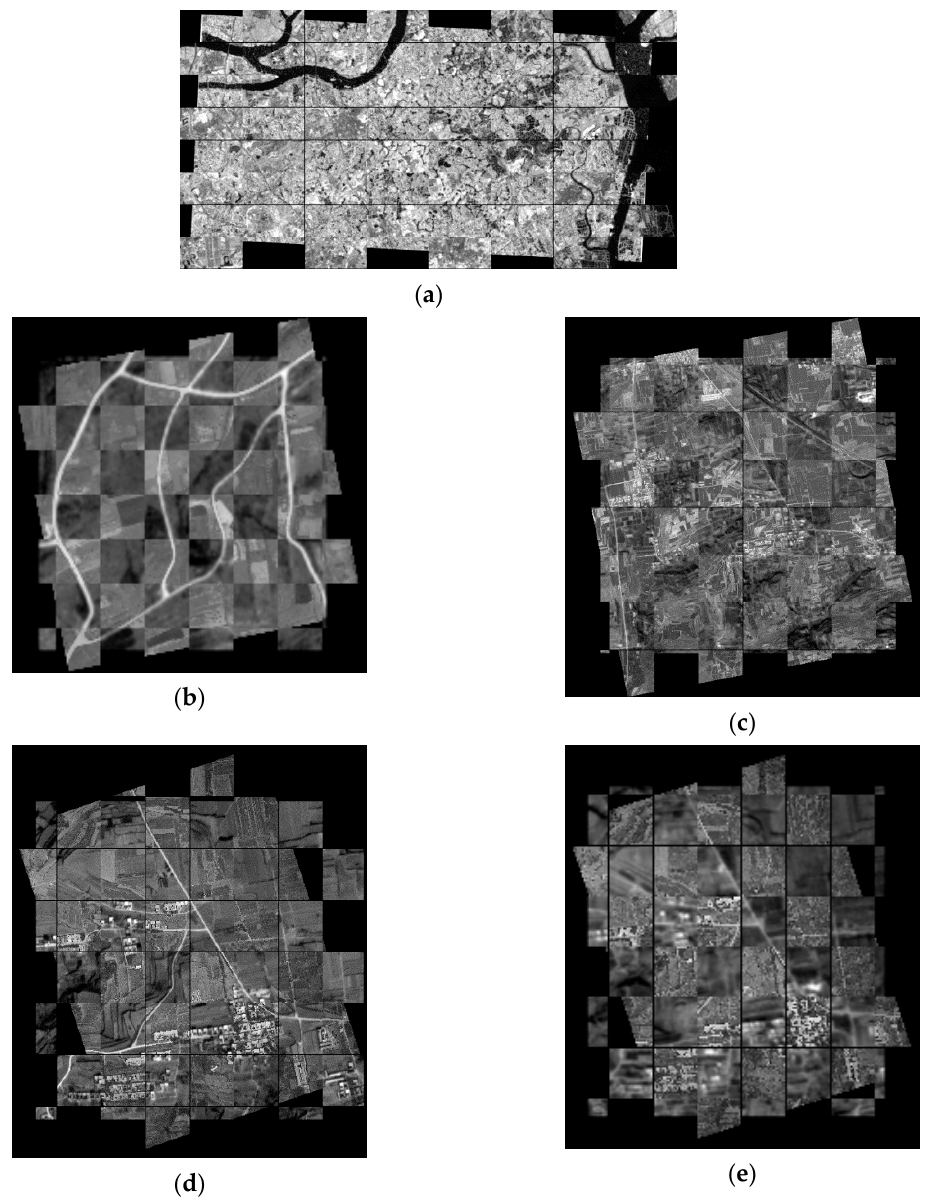
Figure 9. Registration results using the proposed method displayed as a checkerboard mosaicked image. ( a )–( e ) are registered images for No. 1–5 image pairs.